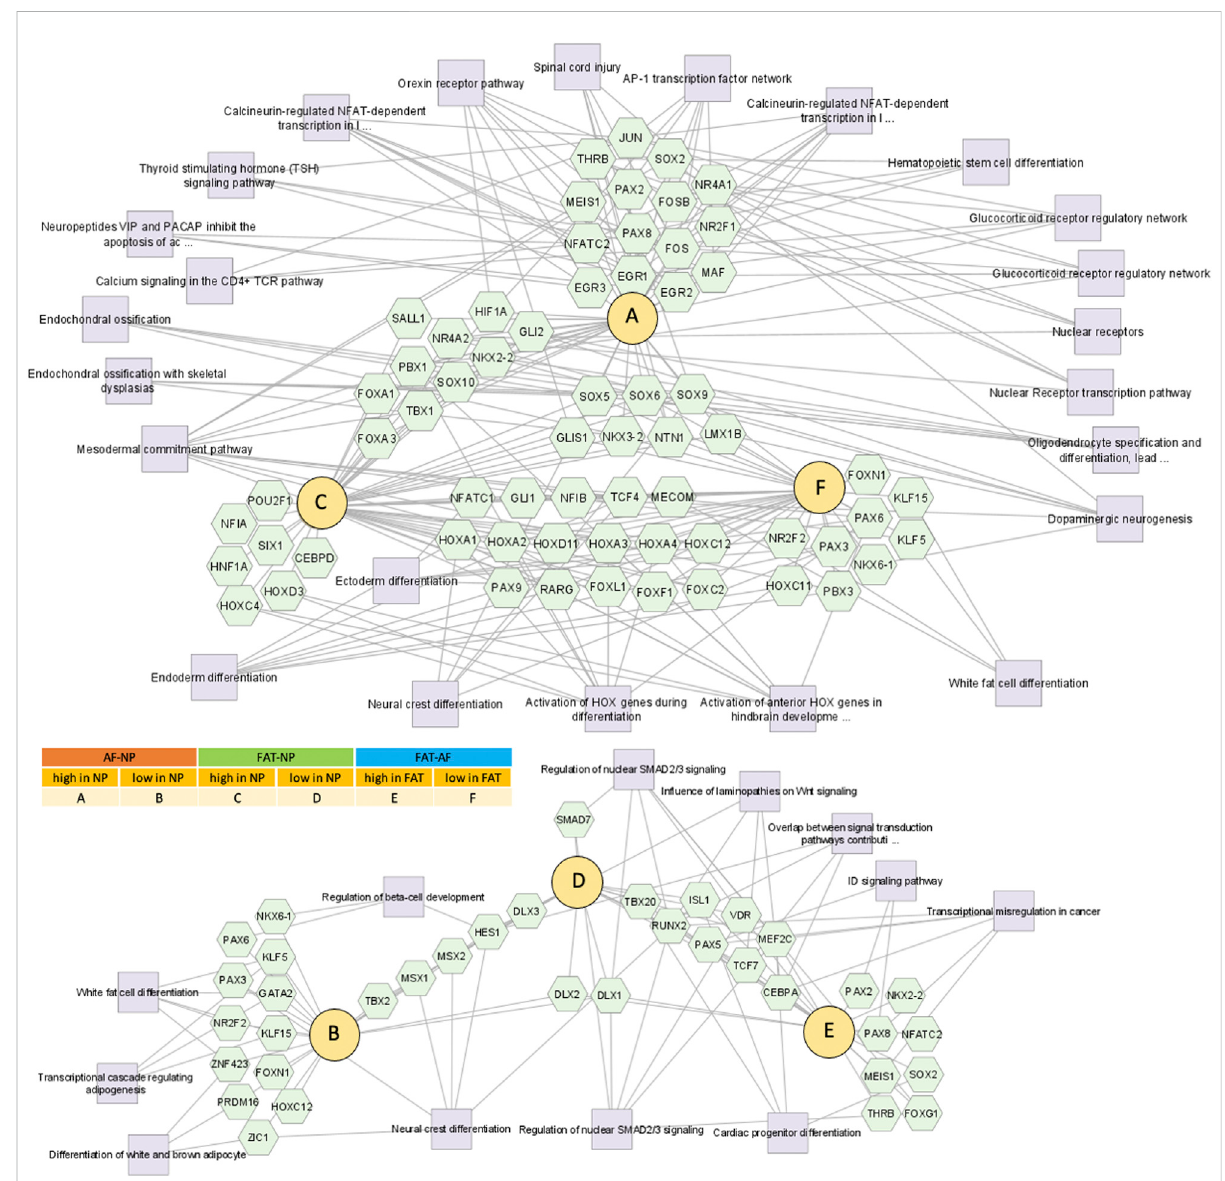
FIGURE 6 Network of differentially expressed transcripts between annulus fi brosus (AF) and nucleus pulposus (NP) cells of the IVD and adipose (FAT) stromalcellsassociatedwiththefunctionalenrichmenttermDNAbindingtranscriptionfactoractivity(GO:0003700).Networksweregeneratedwith ToppCluster andanalyzedinCytoscape. Cellswereisolatedfromasingledonortoavoidthegenotypeeffect. Cellswereanalyzedasthreereplicates for AF and NP and two replicates for FAT cells. Nodes are identi fi ed in the